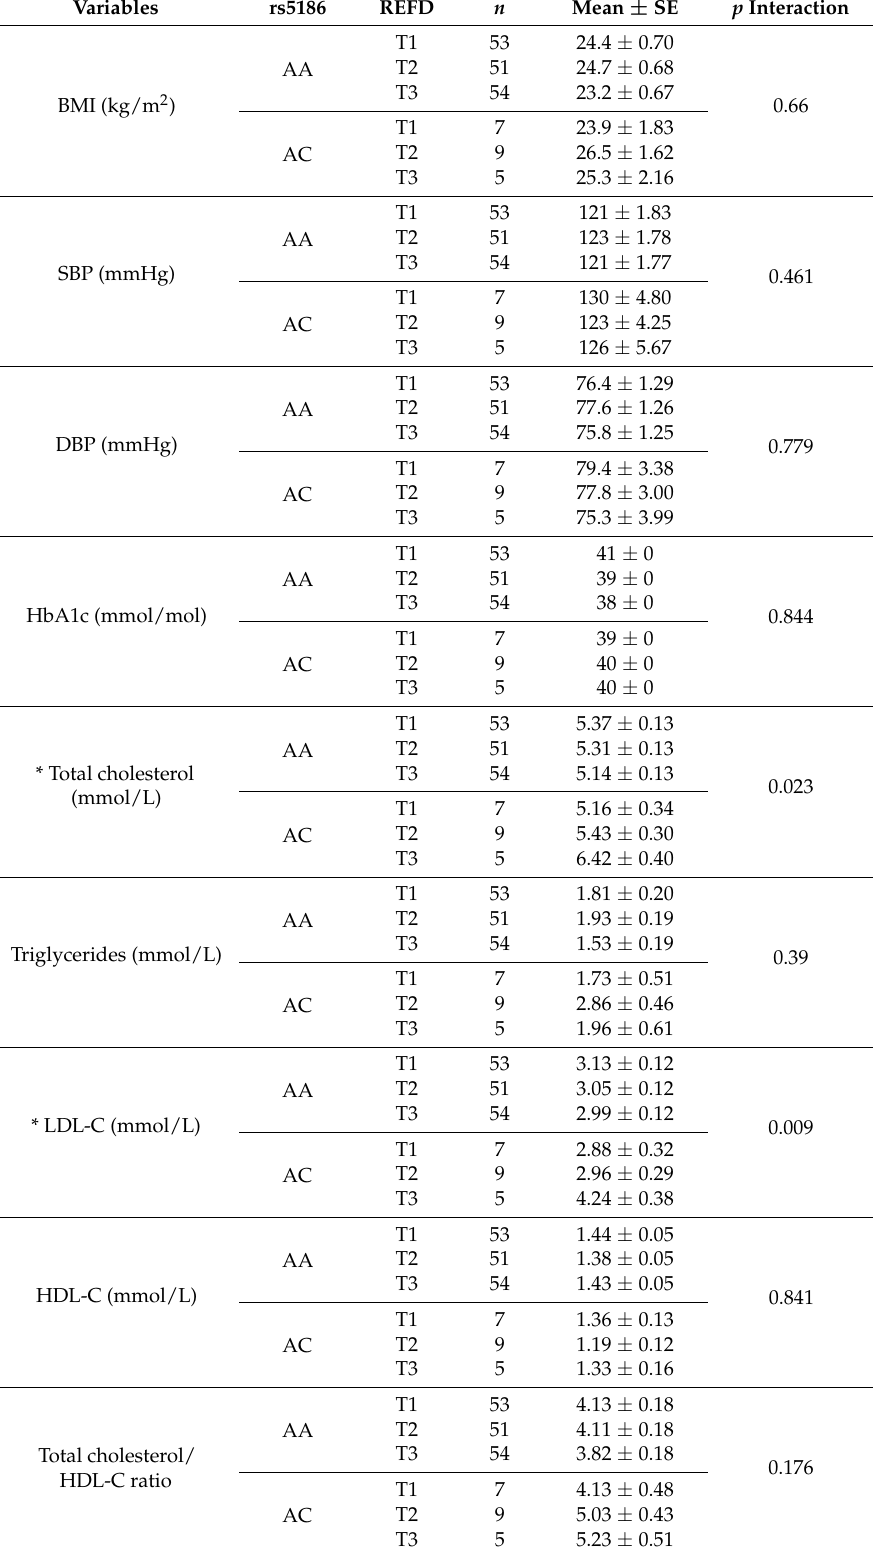
Table 6. Interaction between tertiles of “rice, egg, and fish diet” (REFD) and genotypes of the AGTR1 gene rs5186 SNP on the metabolic risk factors of CVD in Chinese